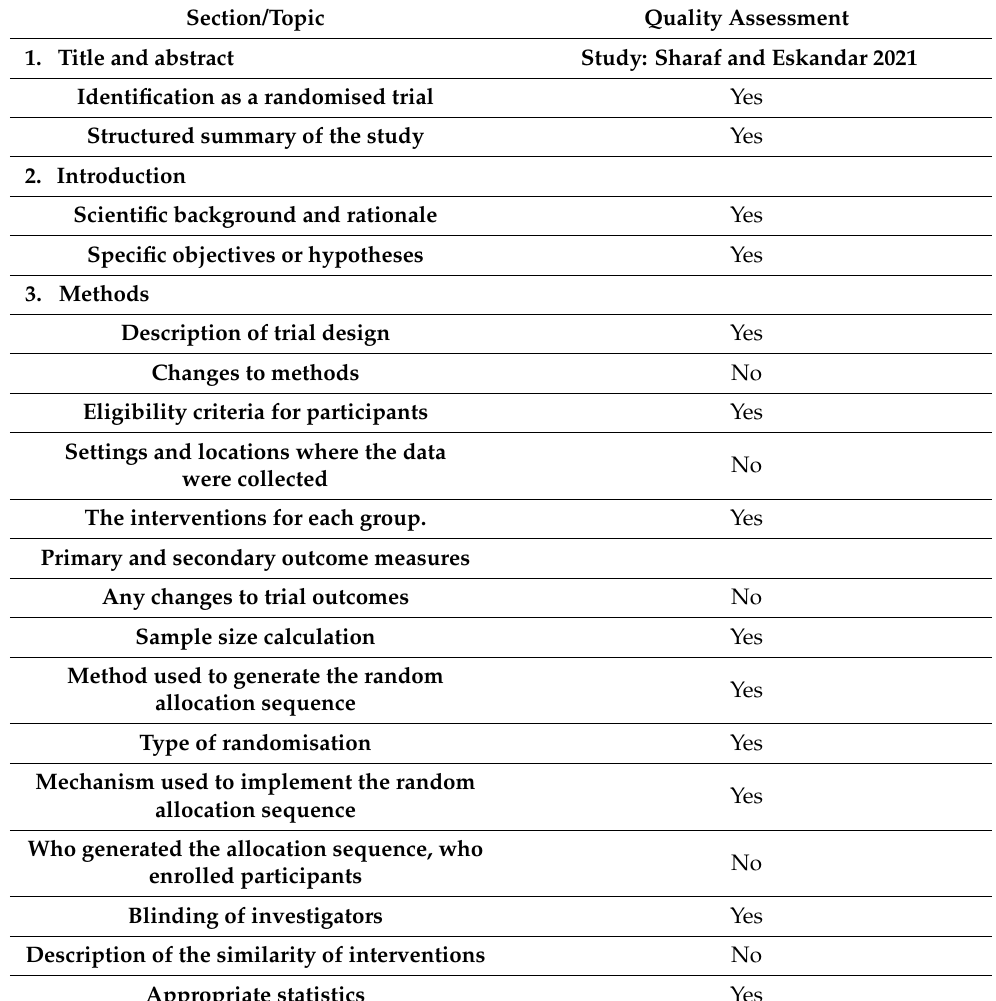
Table 6. Quality assessment results of the quality assessment of the randomised controlled trial included in this